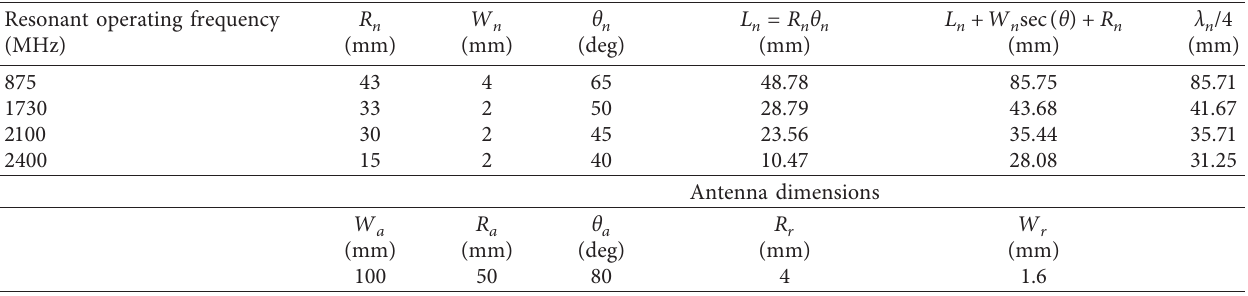
Figure 8: Antenna design iterations, introduction of slots for multiband response and vacant quarter ring to improve Table 2: Parameters of the proposed slotted cross-dipole antenna.